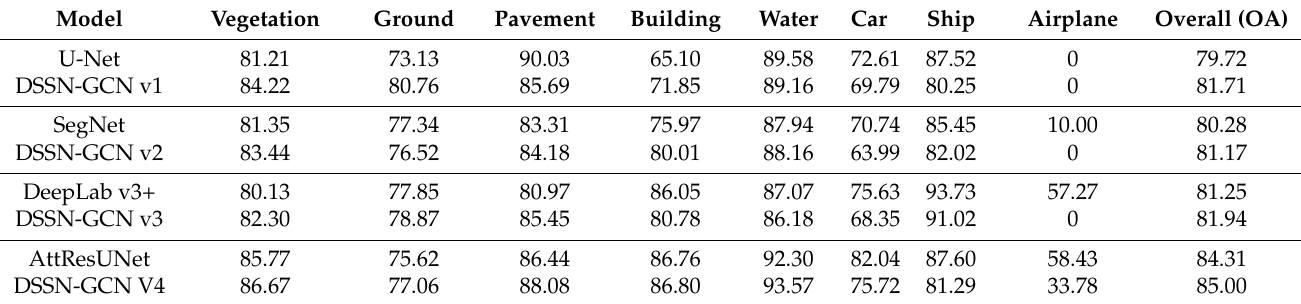
Table 4. The overall accuracy (OA) (%) of semantic segmentation on the UCM